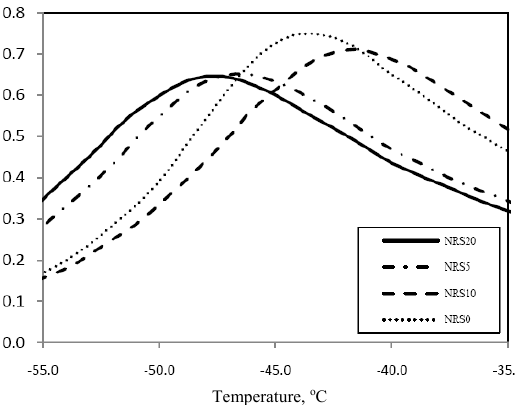
Figure 15. Tg of samples at various silica ratios.